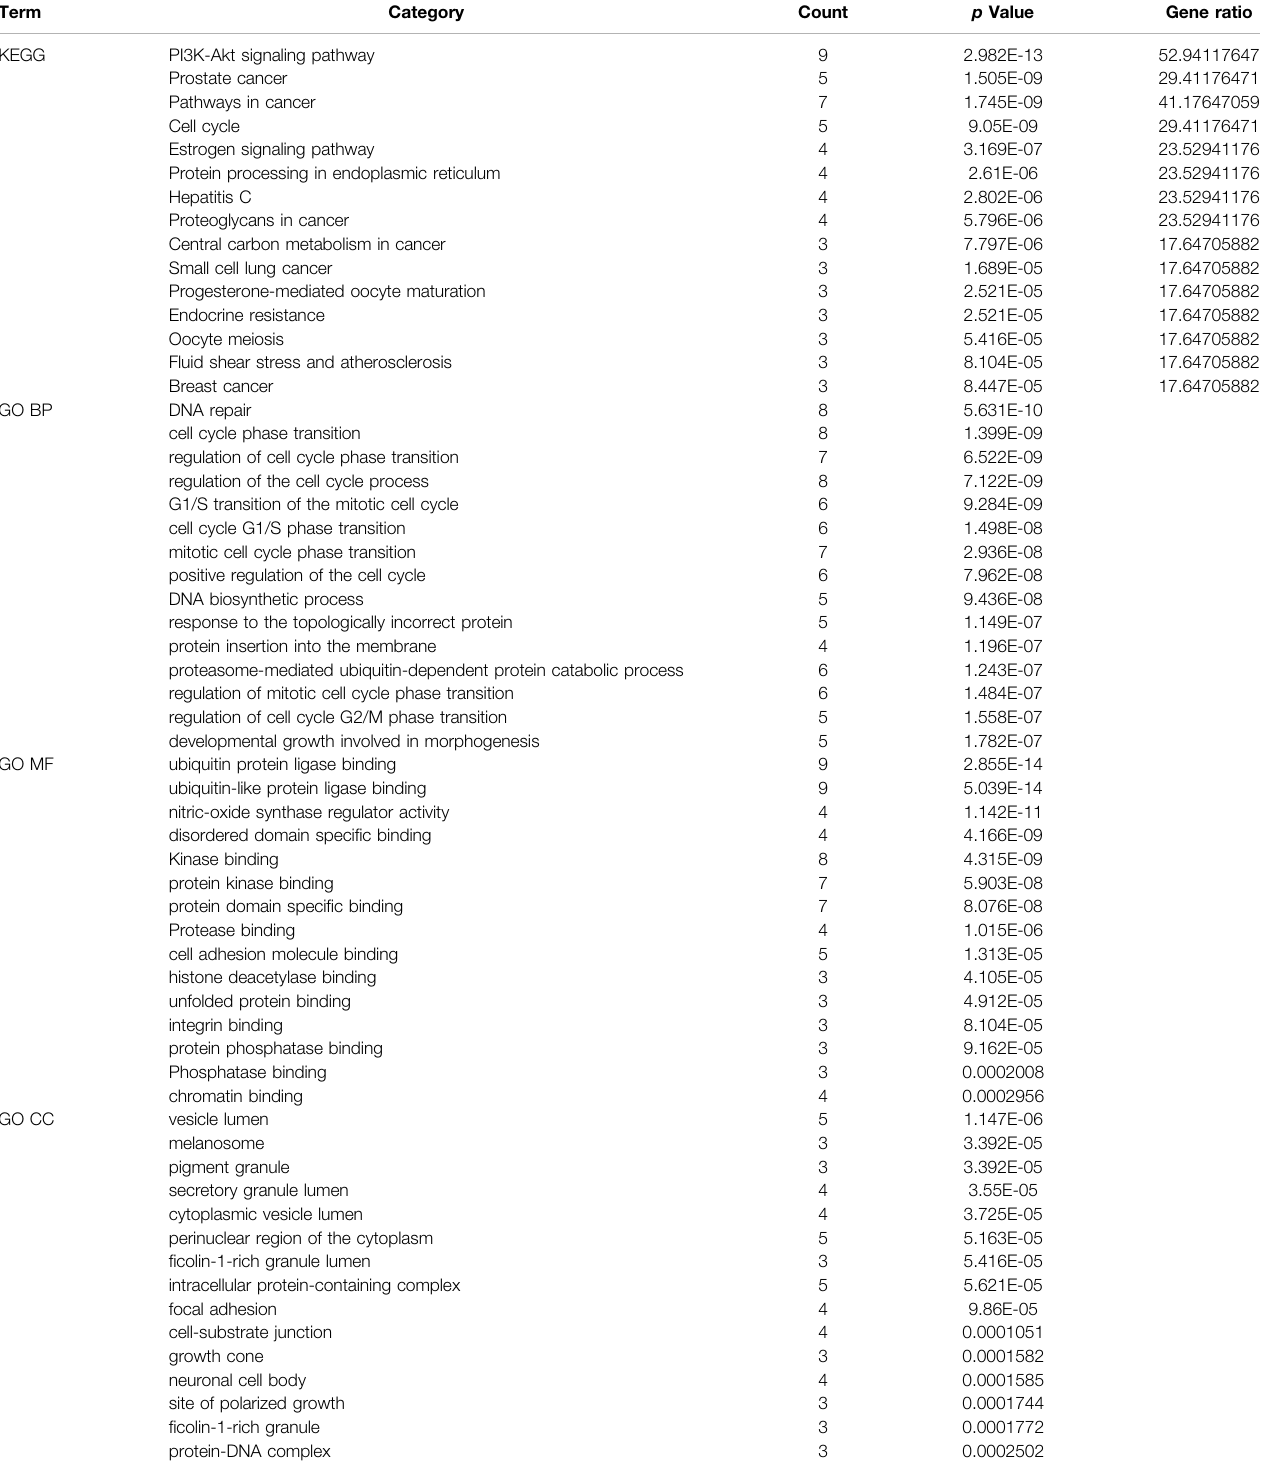
TABLE 4 | Functional enrichment of the core targets of BTP-DEGs. Term Category Count p Value Gene ratio KEGG PI3K-Akt signaling